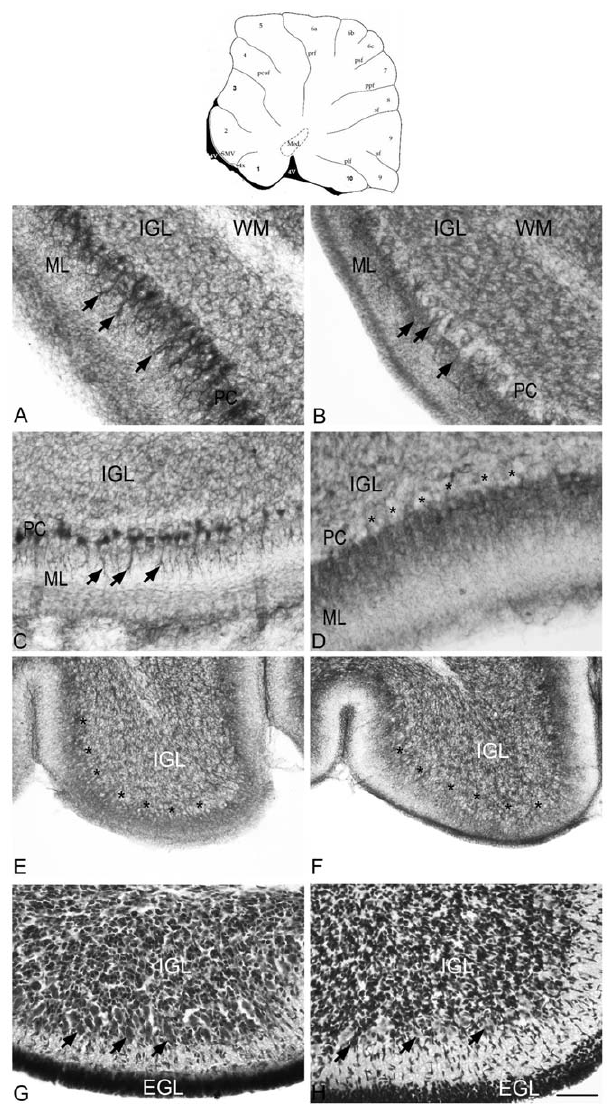
Figure 1. Pattern of NADPH-d labeling in Purkinje cells at P9 shown here after gray-scale conversion of the original color image. The scheme in the uppermost part of the figure indicates in bold and italic the folia shown in the figures A to H, at the vermis region (0.5 mm mediolateral distance). Med - medial (fastigial) cerebellar nucleus; Pcuf - preculminate fissure; Prf - primary fissure; Psf - posterior superior fissure; Ppf - prepyramidal fissure; Sf - secondary fissure; Uf - uvular fissure Plf - posterolateral fissure; ML - molecular layer. A, B: At folium 3 in SHAM animals (A), Purkinje cell bodies have a strong labeling and the dendritic trees are well defined by NADPH-d staining (arrows), while in HI animals (B), cell bodies have a weaker staining with a less defined staining pattern in the dendritic arbors (arrows). C, D: At folium 1 in SHAM animals (C), both cell bodies and processes have a strong labeling (arrowheads), while in HI ones (D), the cell bodies do not present NADPH-d activity (asterisks in the presumptive PC). Observe in D that the ML presents a strong and diffuse staining that corresponds to the location of the dendritic trees of the Purkinje cells. E, F: At folium 10, none of the groups presented NADPH-d staining in Purkinje cell bodies or in the dendritic arbors (asterisks in the presumptive PC). The presence of Purkinje cells was verified by hemaetoxilin staining in an adjacent section (G – SHAM; H – HI, arrows). WM=white matter; IGL=internal granular layer; EGL=external granular layer. Calibration bar: A–D, G and H=50 m m, E and F - 100 m m.